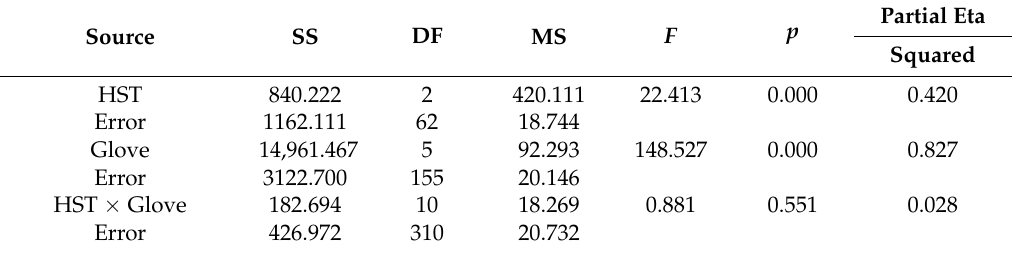
Table 4. Results of the analysis of variance (ANOVA) for grip strength measured at three hand skin temperatures and six glove conditions (bare-hand and five glove conditions).